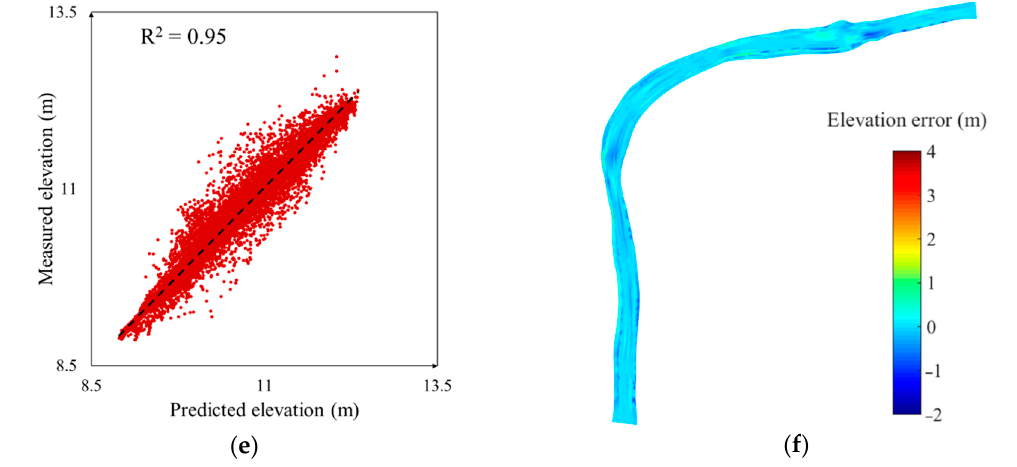
Figure 5. Validation of the generated Baxter River channel topography by three kinds of scenarios. The scatter plot of predicted versus measured values for ( a ) direct linear interpolation (DLI), ( c ) coordinate system transformation (CST) and ( e ) the proposed CST+DCW algorithm. The spatially distributed riverbed elevation error map resulted from ( b ) DLI, ( d ) CST and ( f ) the proposed CST+DCW algorithm.